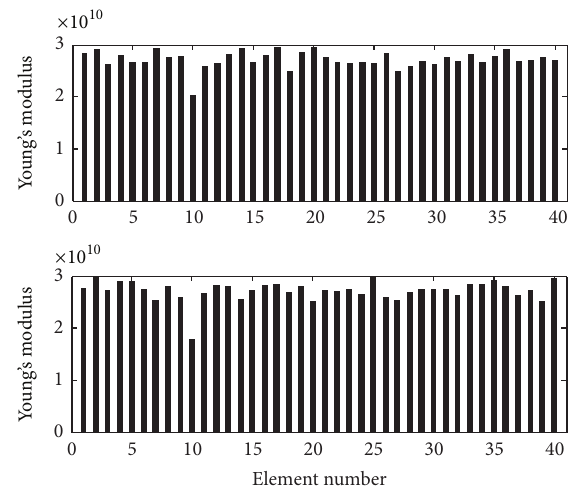
Figure 6: Identified equivalent Young’s modulus from second part for damage at tenth